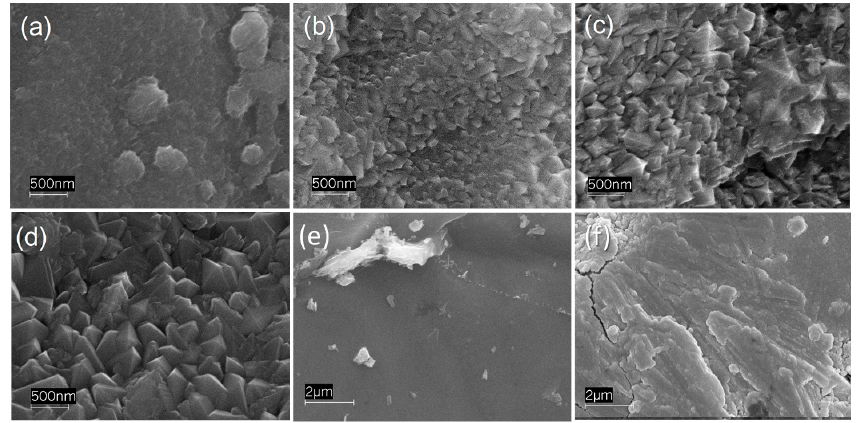
Figure 3. SEM images of TiO 2 coatings prepared by radio frequency (RF) magnetron sputtering with ( a ) 1 h; ( b ) 3 h; ( c ) 6 h; and ( d ) 8 h deposition times; ( e ) Surface of the bare metal Ti disk surface; and ( f ) Pt film deposited on the back side of the titanium disk.